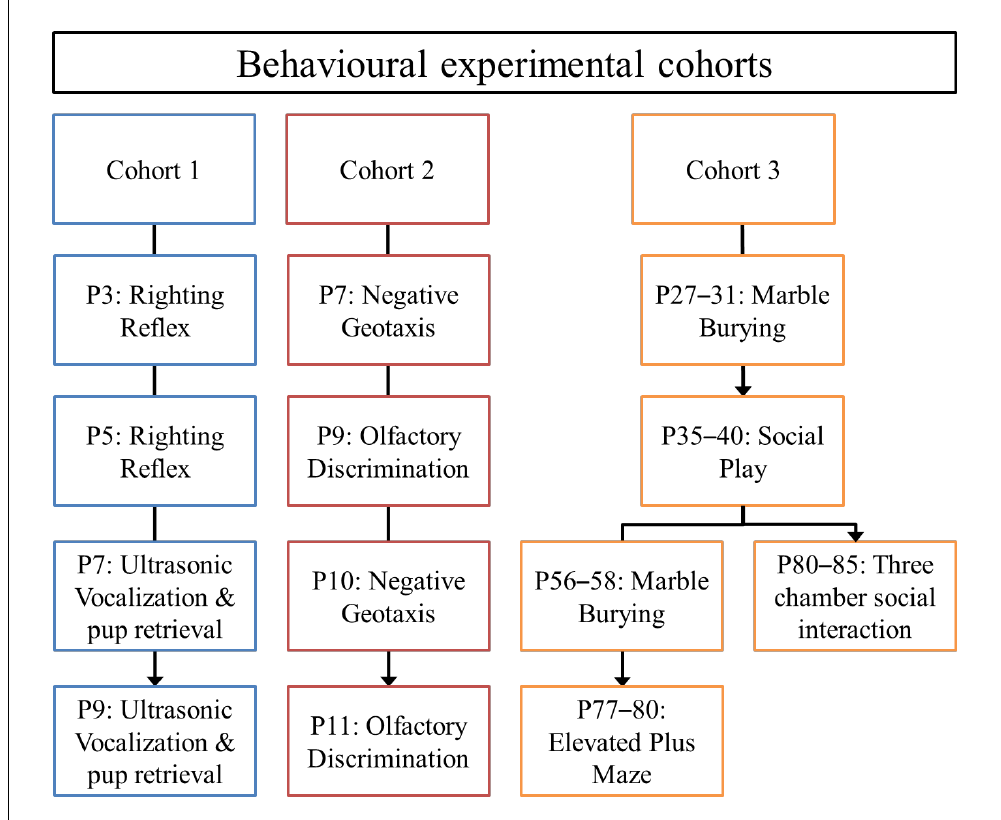
Figure 1. Three separate cohorts were used to assess behaviors in neonates, adolescent and adult rats. Animals were repeated tested at di ff erent ages to both assess developmental trajectories and long-term behavioral changes, P = postnatal